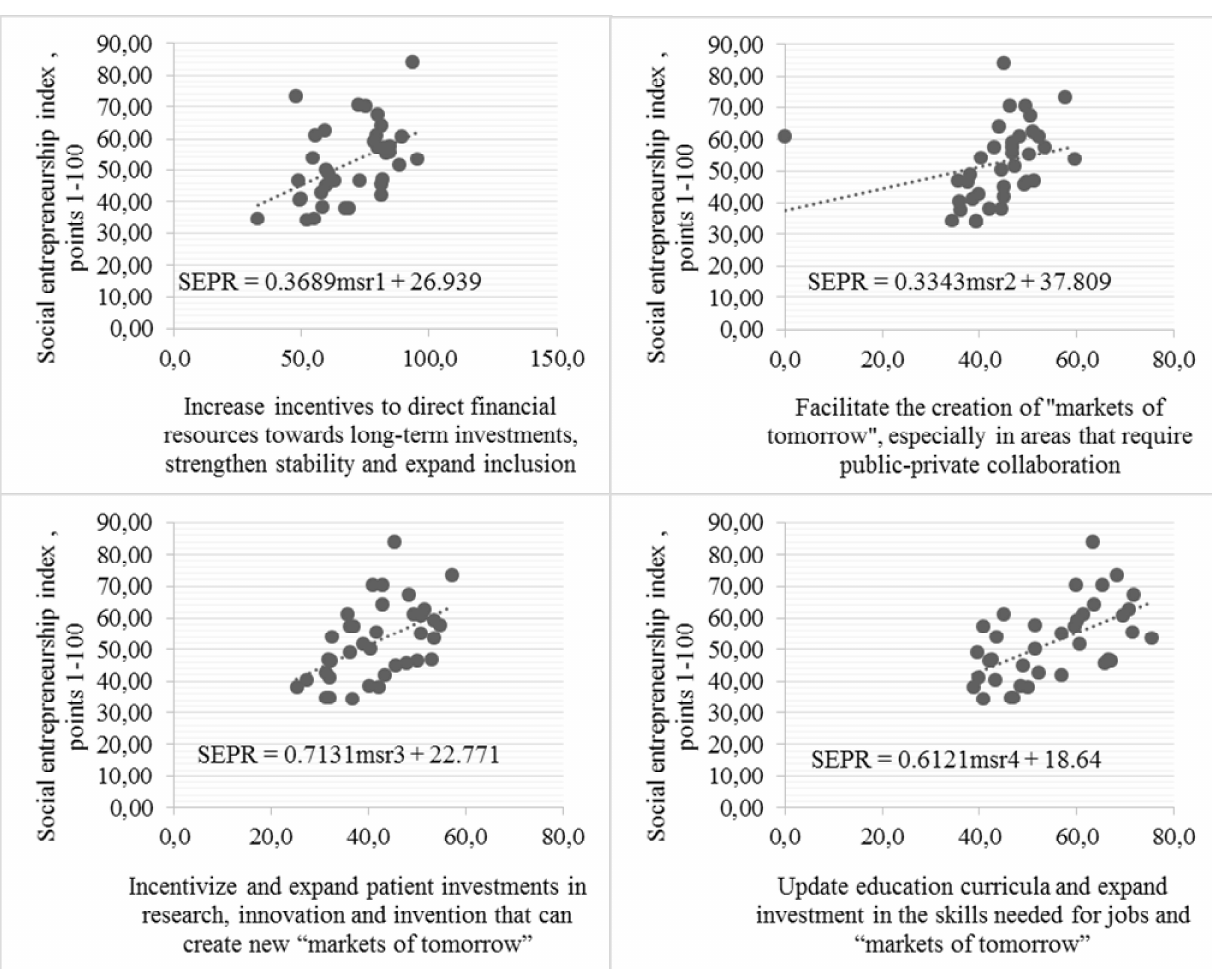
Figure 5. Residual graphs. Source: Obtained by the authors automatically with the help of the “Regression” function in Microsoft Excel.